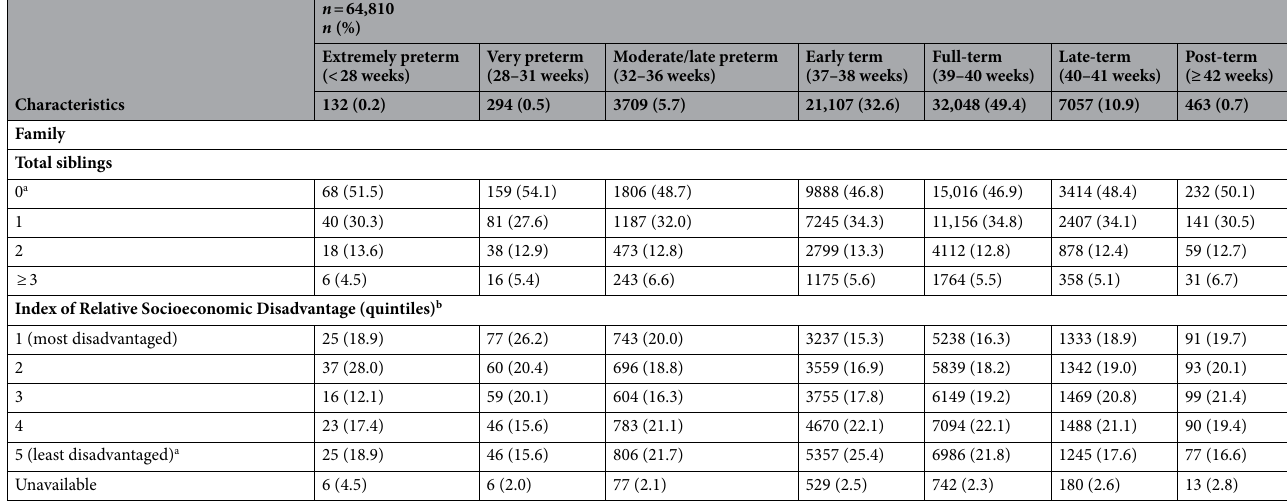
Table 1. Sociodemographic Characteristics of the Study Cohort. a Reference group for regression analysis. b Maternal occupation status are classified into five categories in line with Australian Socioeconomic Index 2006 (AUSEI06); low AUSEI06 values represent low-status occupations. c Categorised as nationally defined quintiles (1 = most disadvantaged to 5 = least disadvantaged); as quintiles are defined nationally (rather than within study population), numbers within each category vary from 20% of